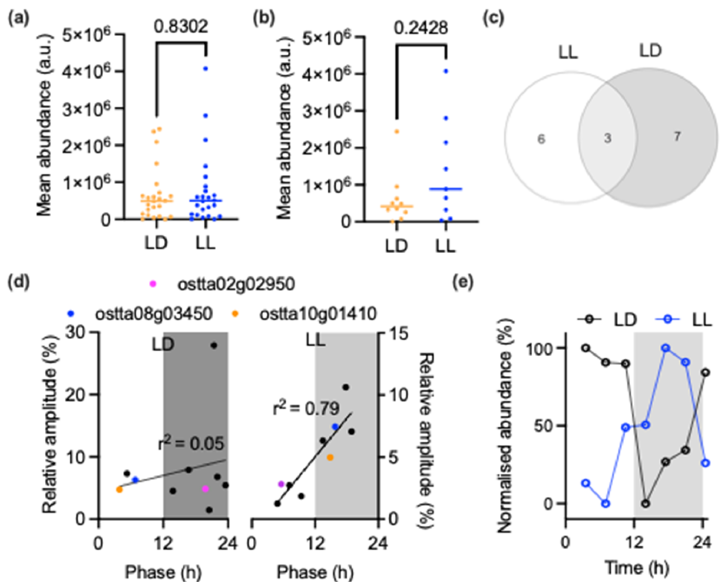
Figure 3. Rhythmicity parameters of selenoproteins: ( a ) Mean abundance of all selenoproteins under LD versus LL conditions. ( b ) Mean abundance of selenoproteins classed as rhythmic under LD versus LL conditions. Statistics in ( a , b ) are unpaired nonparametric tests (Mann–Whitney); data are reported in arbitrary units (a.u.). ( c ) Overlap between rhythmic selenoproteins under LD versus LL conditions. ( d ) Peak abundance phase versus relative amplitude of rhythmic selenoproteins under LD (left) or LL (right) conditions. Coloured data points represent proteins that are arrhythmic under both conditions. Lines are linear regression with annotated r 2 values. ( e ) Protein abundance across LD versus LL for ostta08g03450. The LD data reflect the single LD cycle, while the LL data are mean values across the three LL cycles in [23].